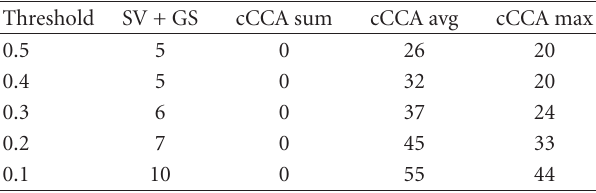
Table 2: Number of voxels a ff ected by the smoothing artifact for di ff erent data analysis methods as a function of P > threshold in memory activation data for contrast “encoding” minus